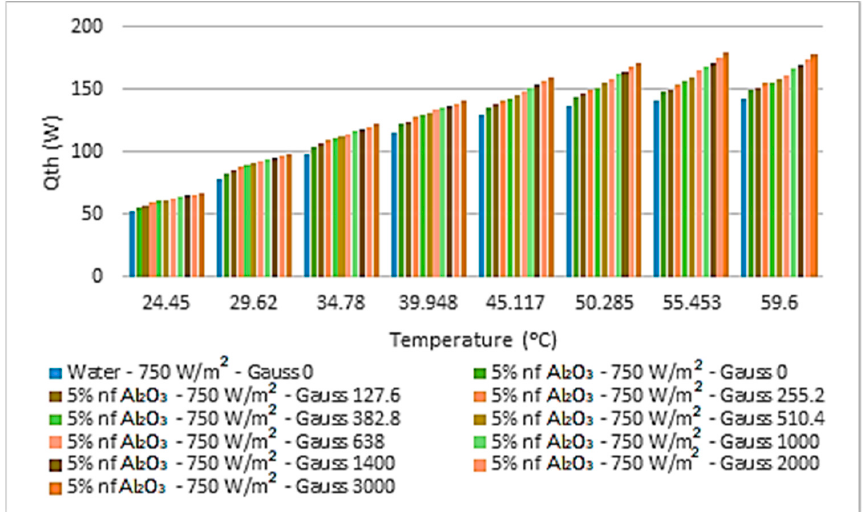
Figure 4. Thermal energy generated by PV-Th solar panels.